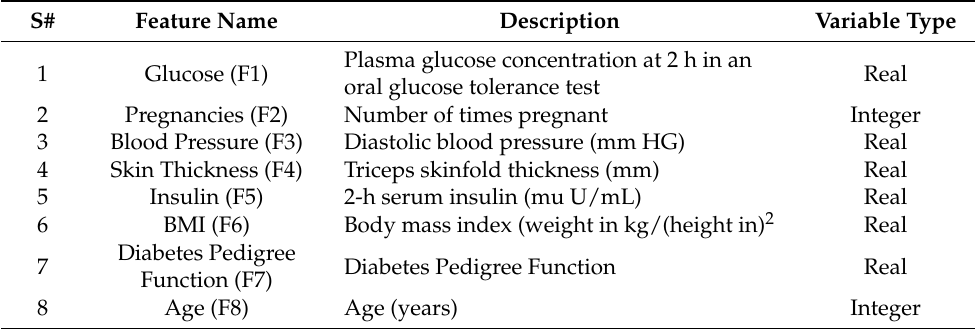
Table 2. Diabetes Datasets—Features Description.